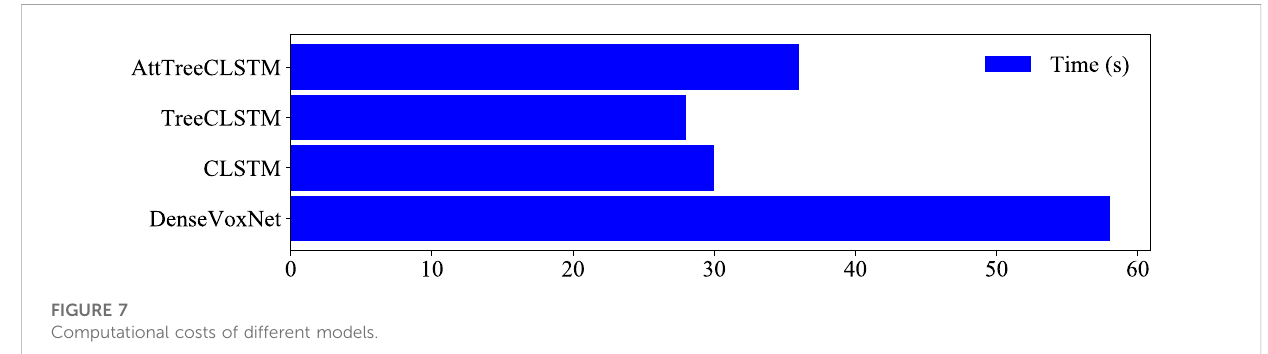
1.2 1.3 1.3 The bold value indicates the best performance.